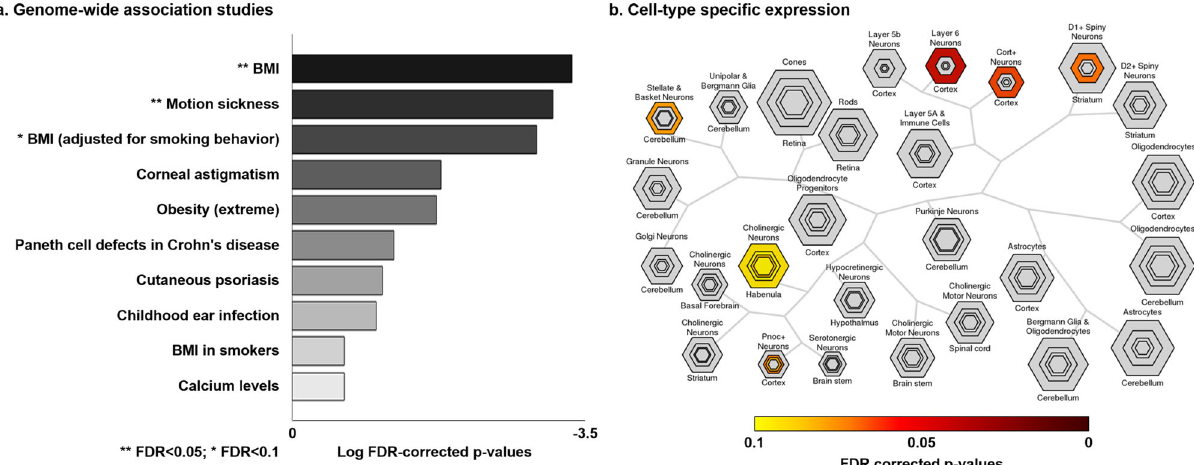
Fig. 3 Transcriptomic analysis. a Genes were derived by associating map of BMI-related manifold changes and gene expression maps from Allen Brain Atlas. Top ten categories associated with gene expressions derived from genome-wide association studies. b Cell-type speci fi c expression analysis identi fi ed candidate cell populations associated with genes expressed in the input spatial map (see Fig. 1c). The hexagon size represents the proportion of genes speci fi cally expressed in a particular tissue. Varying stringencies for enrichment are represented by the size of hexagons going from least speci fi c (outer hexagons) to most speci fi c (center hexagons) (speci fi city index threshold (pSI) = 0.05, 0.01, 0.001, and 0.0001, respectively) 60 . Colors represent the FDR-corrected p -values. Source data are provided in Supplementary Data